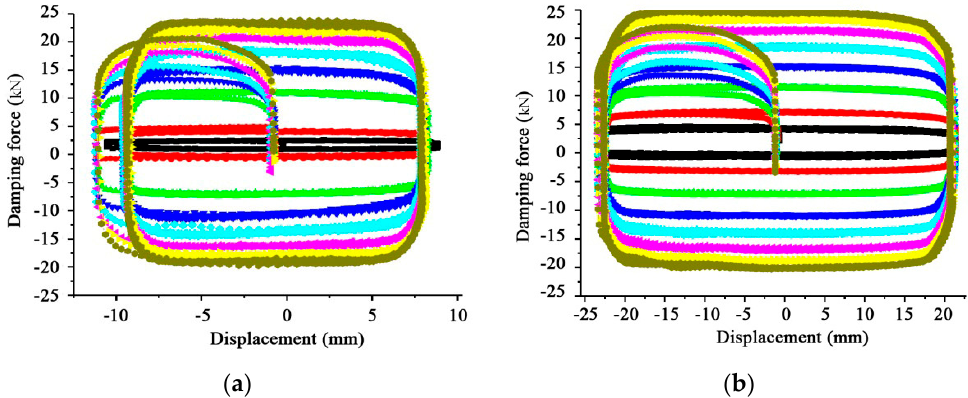
Figure 7. The hysteretic curve under ( a ) an amplitude of 10 mm and 1-Hz sine wave, and ( b ) an amplitude of 20 mm and 0.5 Hz sine wave.